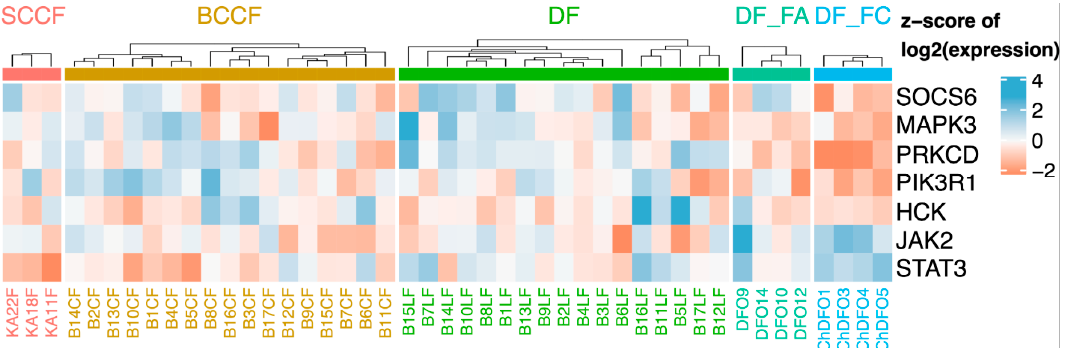
Figure 1. Multiple genes of the interleukin-6 (IL-6) signalling pathway display gradual changes in transcription activity, differing among facial dermal fibroblasts from children (DF_FC), healthy adults (DF_FA), photodamaged dermal fibroblasts (DF) of patients suffering from basal cell carcinoma, and cancer-associated fibroblasts (CAFs) from basal cell carcinomas (BCCF) and cutaneous squamous cell carcinomas (SCCF).